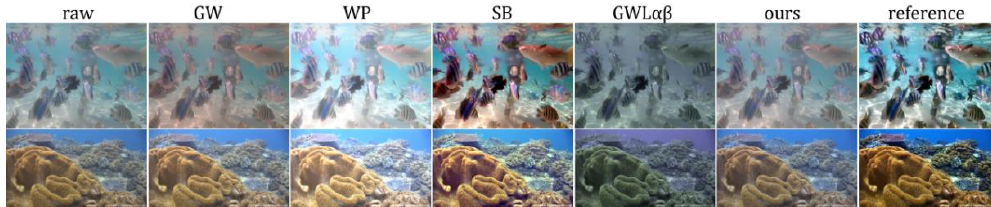
Figure 5. Comparisons on forward looking images. From left to right are raw underwater images, the results of gray-world (GW) method, white-patch (WP) method, statistical-based (SB) method [21], Bianco’s (GWLαβ) method [37], proposed method and reference images.